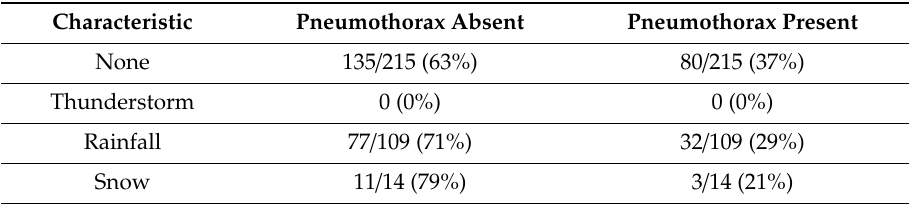
Table 2. E ff ect of the presence or absence of special weather conditions on the rate of pneumothorax after CT-guided lung biopsy. Characteristic Pneumothorax Absent